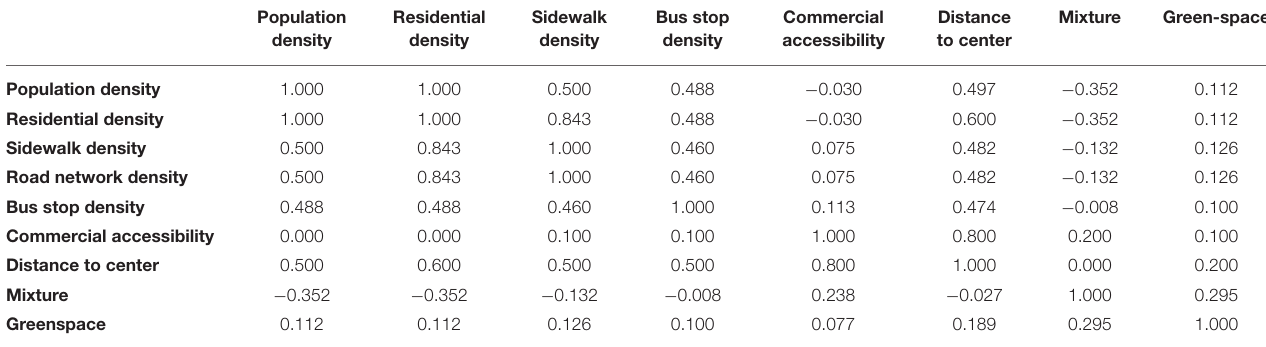
TABLE 3 | Pearson correlation coefficient between explanatory